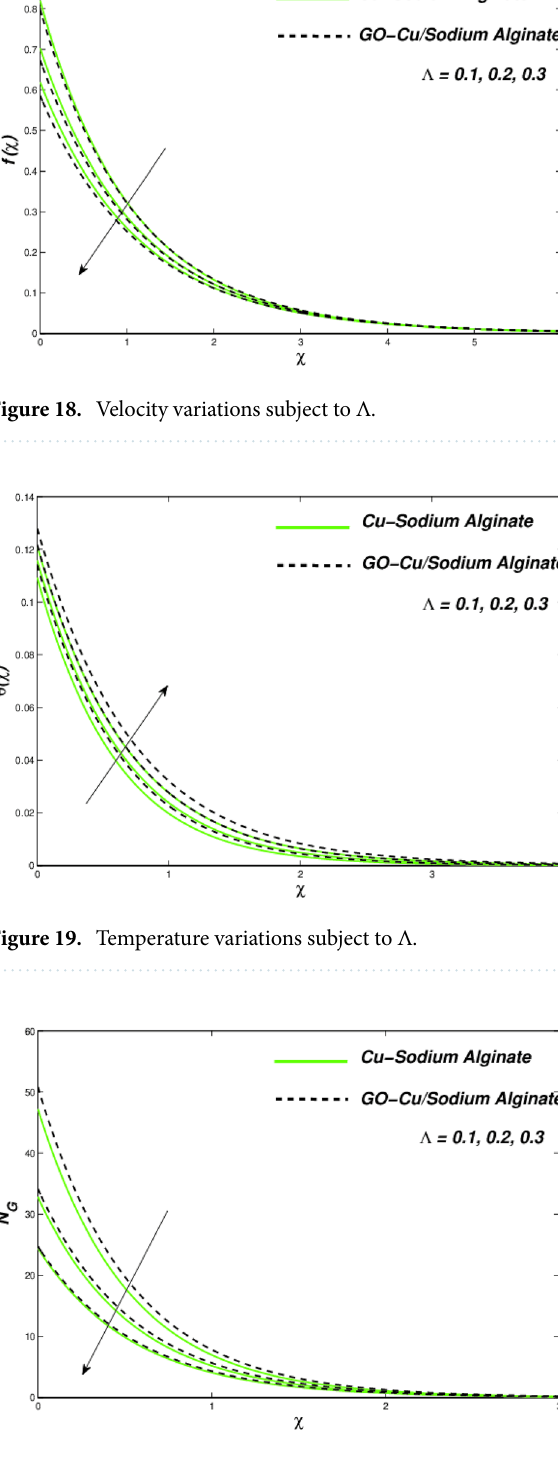
Figure 20. Entropy variations subject to (cid:31)